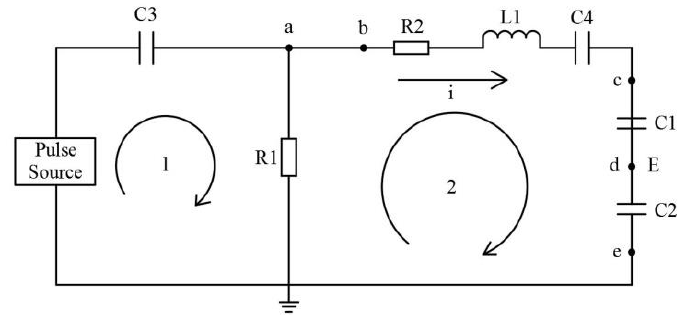
Figure 5. Simplified circuit of coupling network.